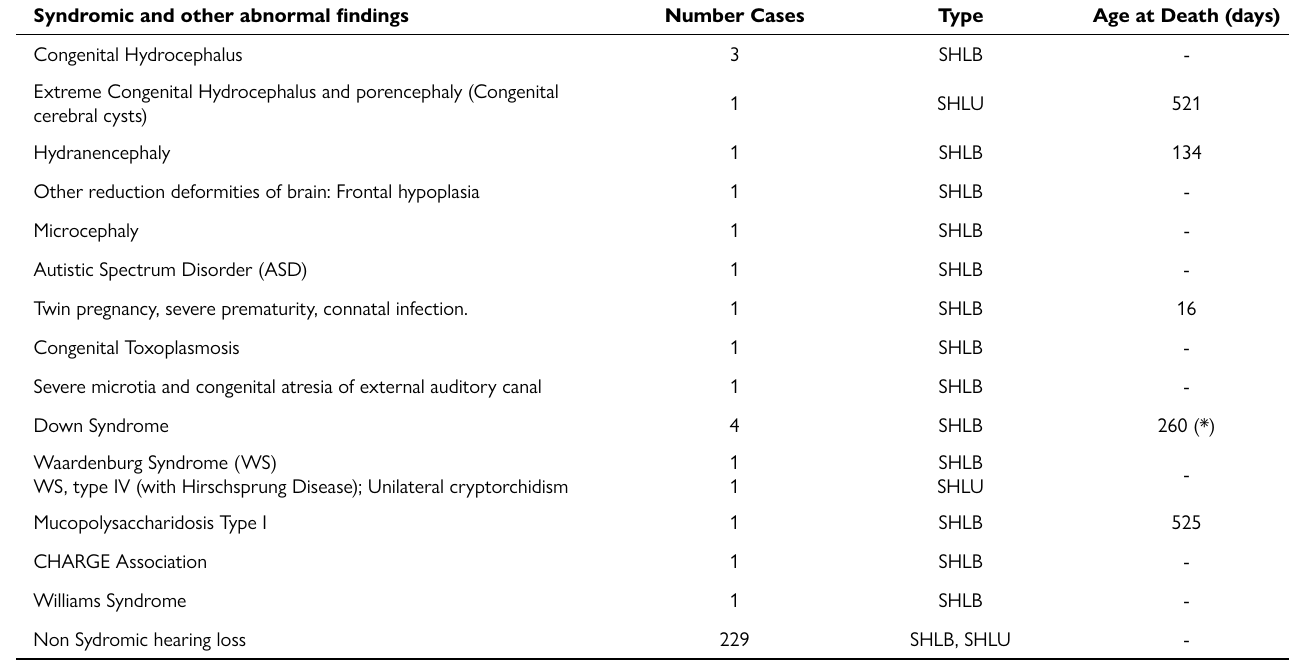
SHLB: Sensorineural hearing loss bilateral (ICD-10 H90.3); SHLU: Sensorineural hearing loss unilateral with unrestricted hearing on the contralateral side (ICD-10 H90.4); (*) one case of Down Syndrome with congenital heart disease. CHARGE (Coloboma of the eye, Heart defects, Atresia of the choanae, Retardation of Growth and development, and Ear abnormalities and deafness); -Not applicable. Total births between 2010 and 2014: